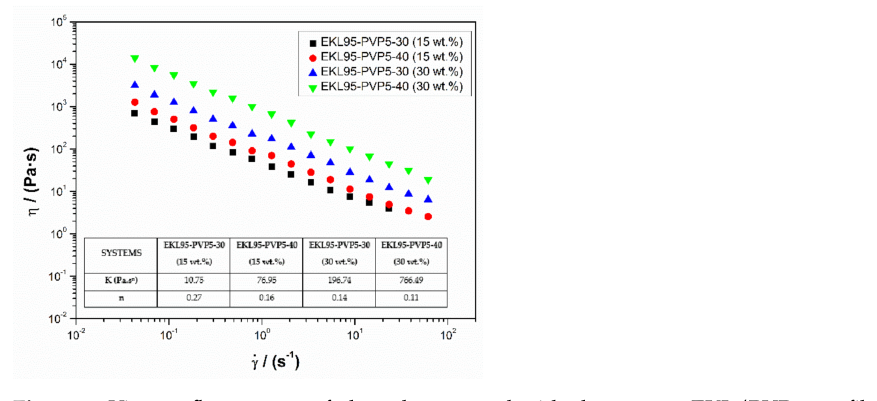
Figure 8. Viscous flow curves of oleogels prepared with electrospun EKL/PVP